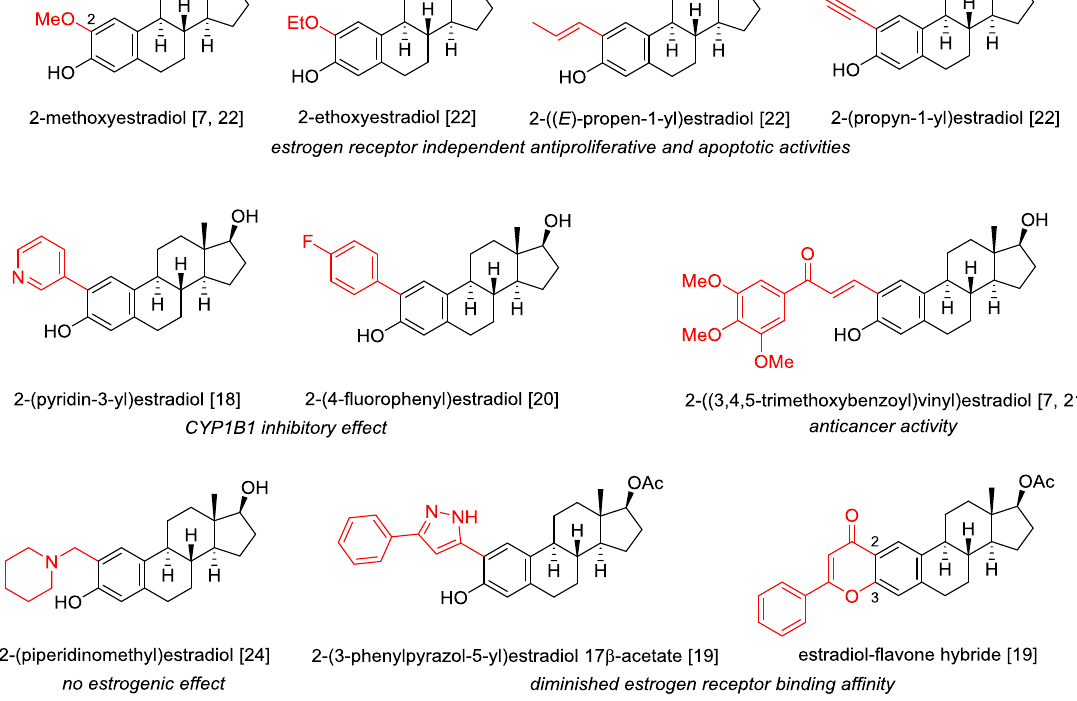
Figure 1. A-ring modified derivatives of estradiol displaying anticancer activity and/or reduced estrogenic action.